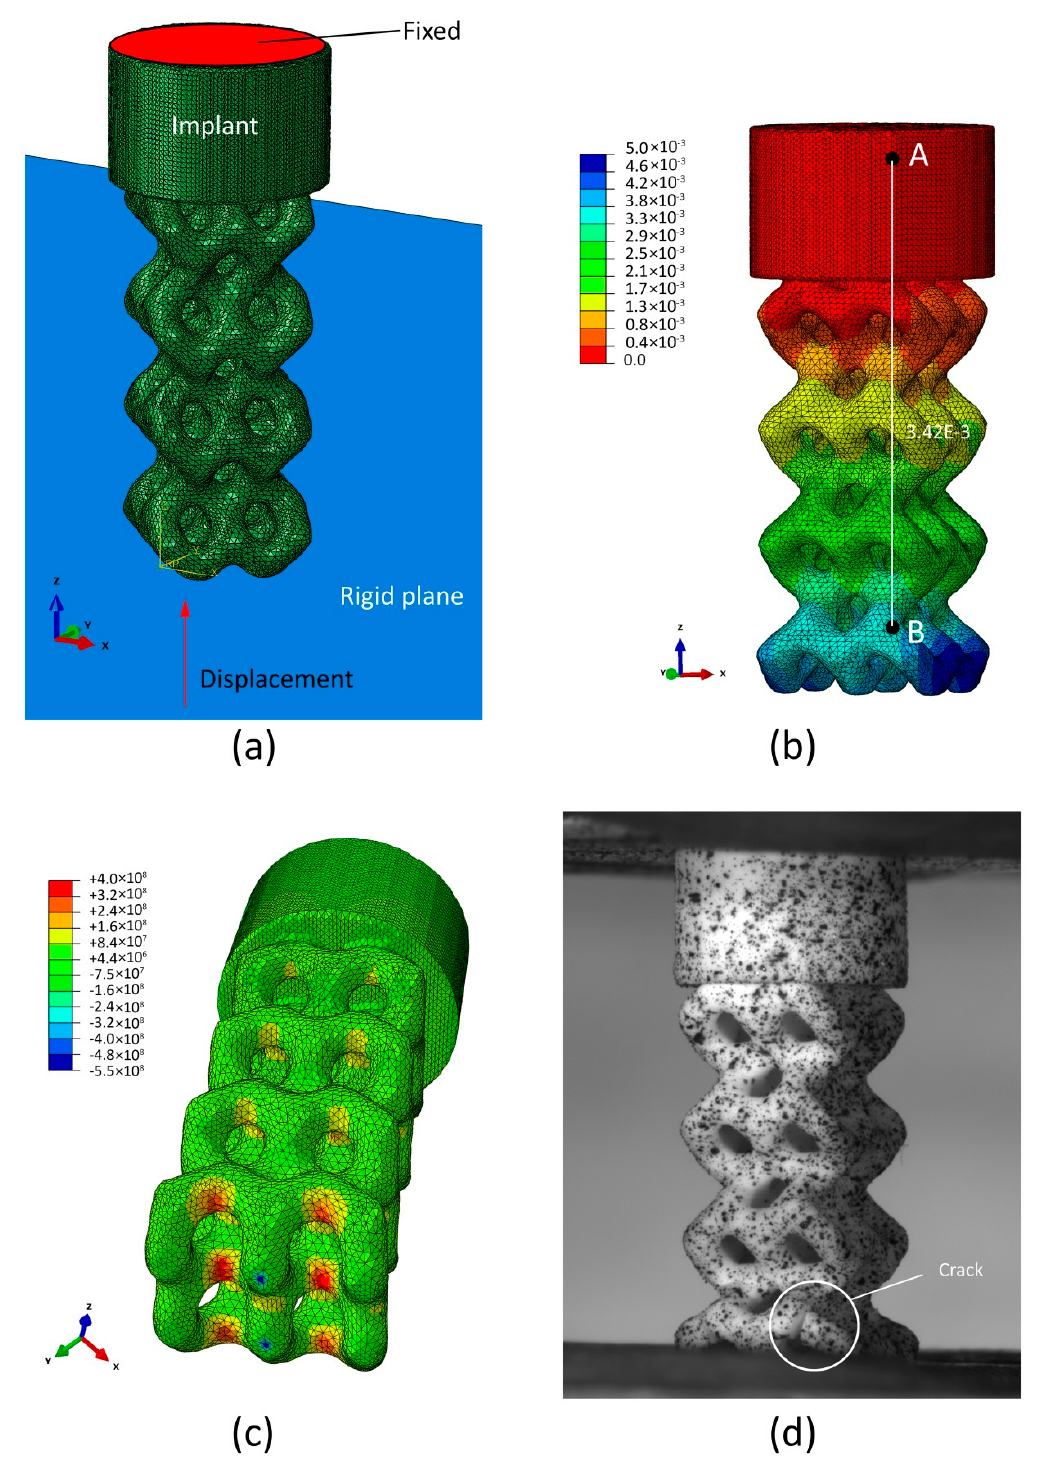
Figure 14. Compression test simulation results for the BI002 specimen: ( a ) Computational model; ( b ) distribution of vertical displacements (mm) at the load of 185.7 N; ( c ) distribution of maximal principal stress (Pa) at the load of 279.9 N; ( d ) initial fracture of the specimen during compression test.